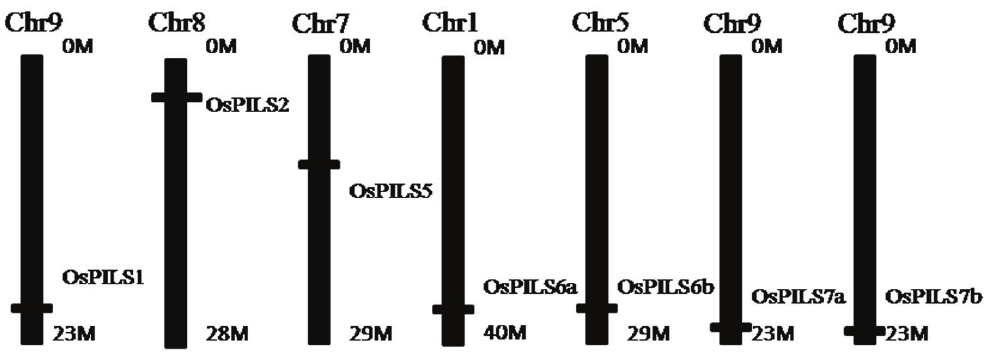
Figure 2. Distribution of OsPILS genes in rice chromosomes. All seven OsPILS genes are distributed toward the distal end of the chromosome. Chromosome 9 harbors three OsPILS genes, whereas chromosomes 1, 5, 7 and 8 harbor one OsPILS gene